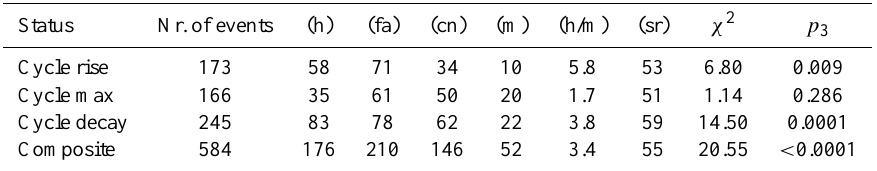
Table 3. Summary information concerning the performance of the HAFv.2 model with respect to data measured during the key (rise/max/decline) phases of solar cycle 23 and over the total cycle. Status Nr. of events (h) (fa) (cn) (m) (h/m) (sr) χ 2 p 3 Cycle rise 173 58 Cycle max 166 Cycle decay 245